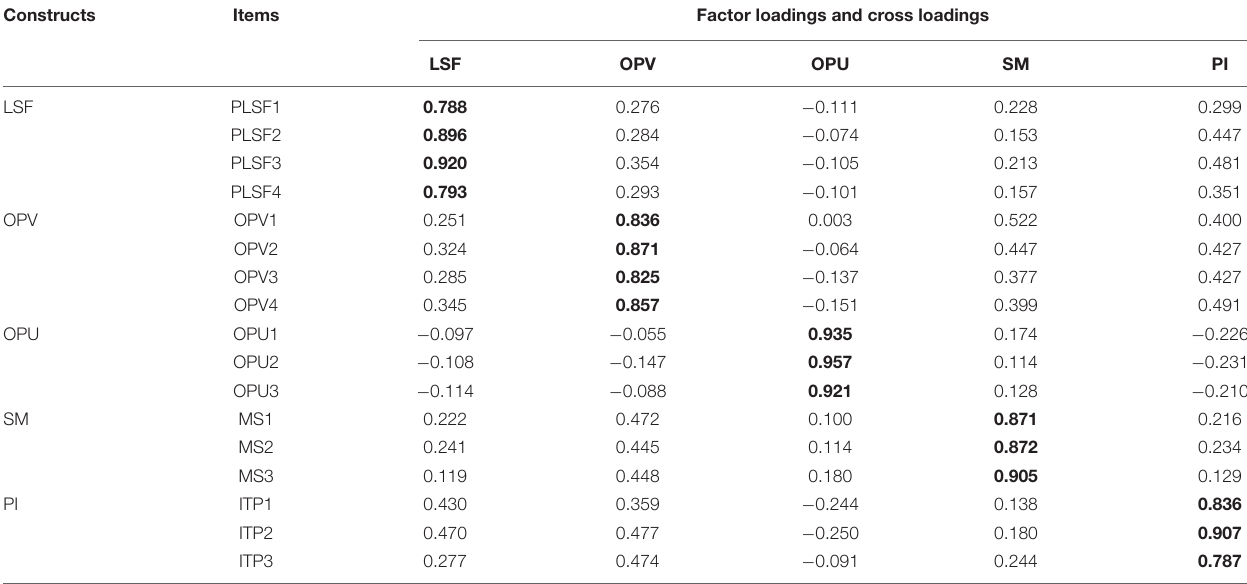
Factor loadings are in bold.